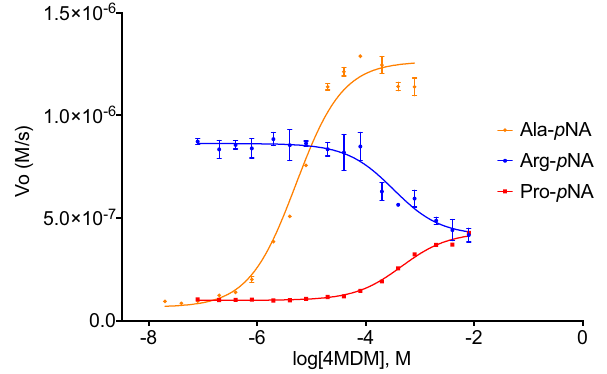
Figure 5. The AC 50 and IC 50 curves for 4MDM were determined using four different substrates Ala- p NA (orange), Arg- p NA (blue), and Pro- p NA (red). Hydrolysis of Arg- p NA by LTA4H was inhibited in the presence of 4MDM with an IC 50 of 328.10 μM. Hydrolysis of Ala- p NA and Pro- p NA was activated by 4MDM with an AC